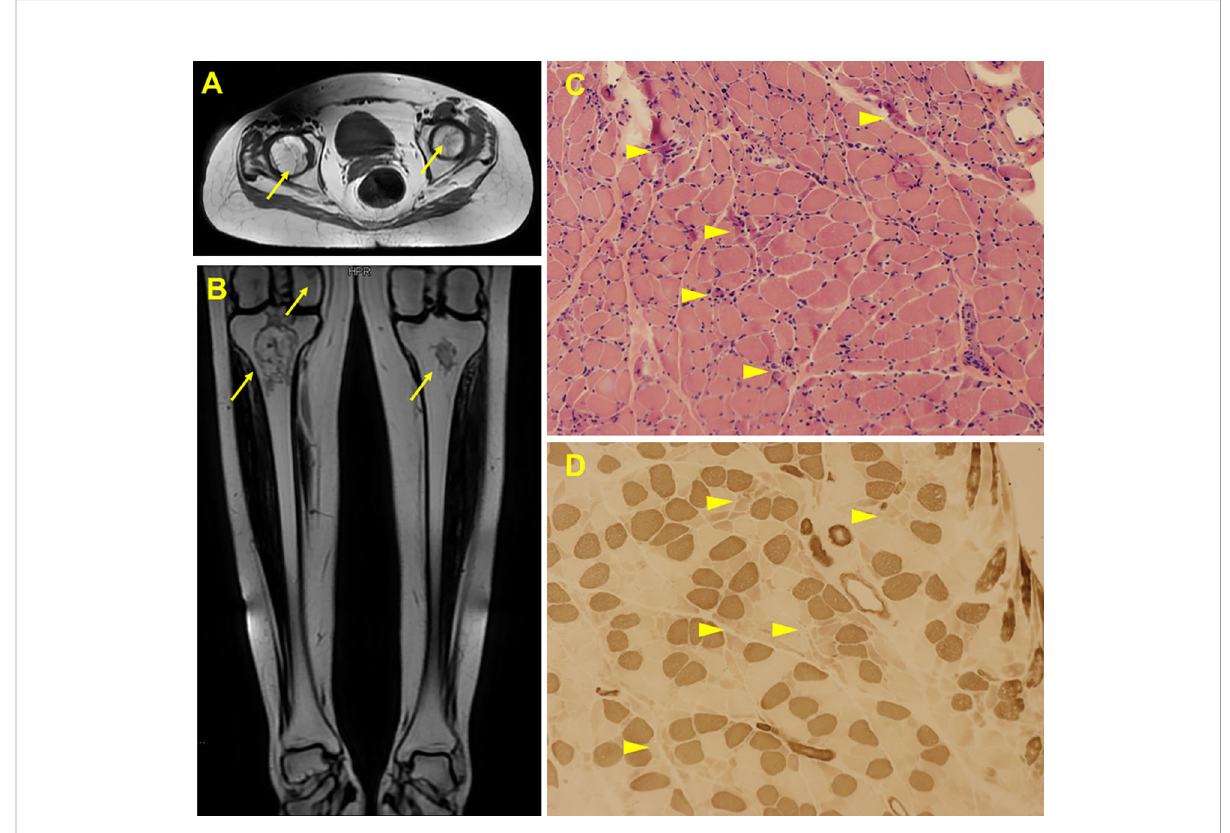
FIGURE 2 Radiological and histological fi ndings of the case. MRI scan showed abnormal signals in bilateral femoral head (A) , distal femur and upper tibia (B) , suggesting ischemic necrosis or infarction. Arrows indicate the lesions. H&E staining of the biopsy showed scattered myo fi ber atrophy (C) . ATPase staining revealed atrophy of type II myo fi bers (D) . Arrow heads indicate the